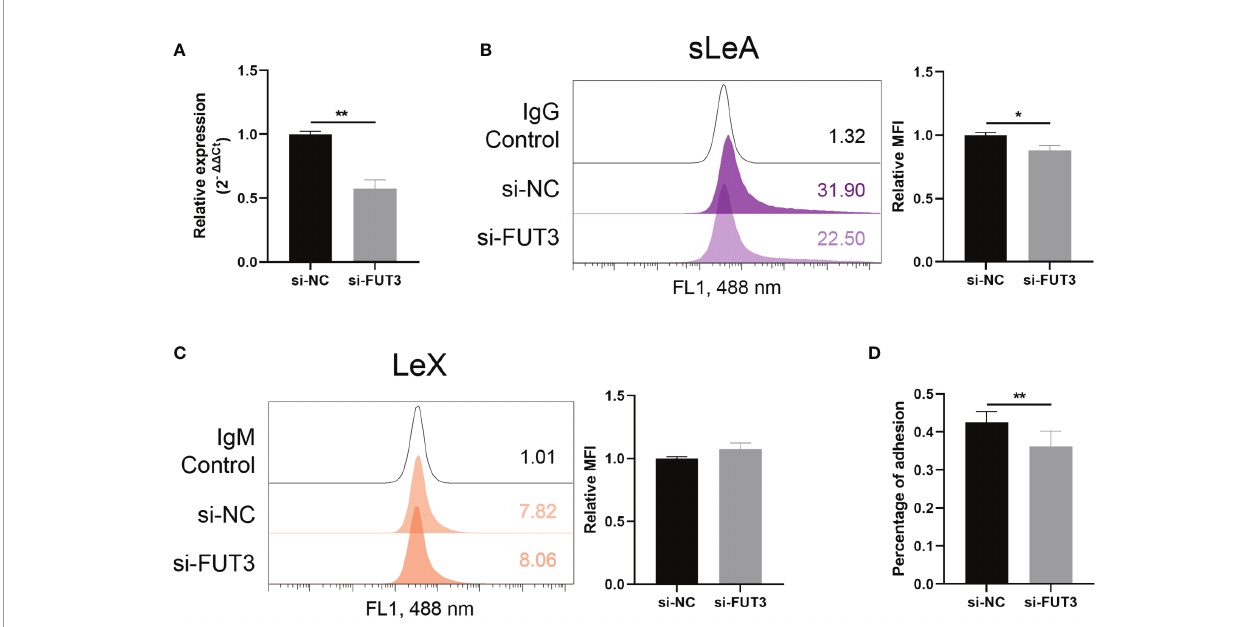
FIGURE 6 | FUT3 knockdown in RL95-2 cells. (A) RT-qPCR demonstrating ef fi ciency of siRNA knockdown of FUT3 in RL95-2 cells. (B, C) Flow cytometry demonstrating reduced expression of sLeA but unchanged expression of LeX after the knockdown of FUT3 in RL95-2 cells, relative mean fl uorescence intensity (MFI) is used for statistical analysis, numbers inside the frame denote the positive cells (%) in a representative experiment. (D) In vitro implantation assay suggesting suppressed trophoblast spheroids adhesion to endometrial monolayer after the knockdown of FUT3 in RL95-2 cells. The total number of transferred spheroids in each well was fi rstly counted, then nonadherent spheroids were aspirated off, washed with DPBS twice and the number of attached spheroids was counted again under microscope. The results were presented as percentage of adhesion spheroids. Statistical analysis was performed in three independent experiments by t test. Error bars, S.E.M. si-NC, negative control siRNA. * P < 0.05, ** P <